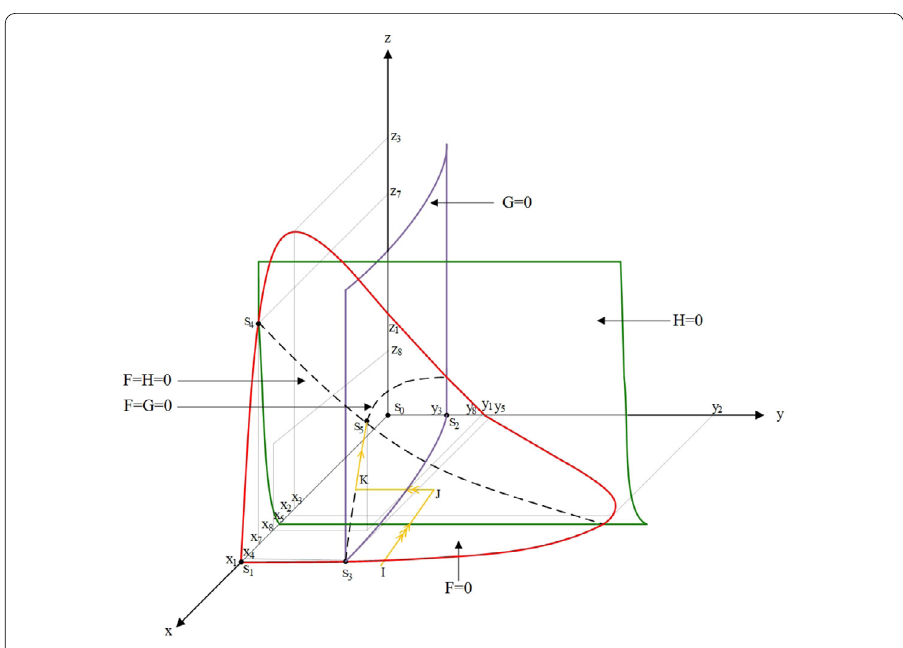
Figure 3 Shapes and relative positions of the manifolds where the parametric values of system of Eqs. (4)–(6) satisfy the conditions in Theorem